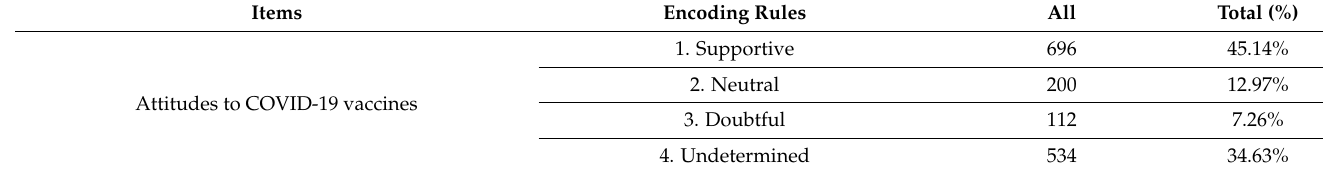
Table 3. Statistical table of coding results (including statistics of sentiment polarity and sentiment attribution pointing to specific